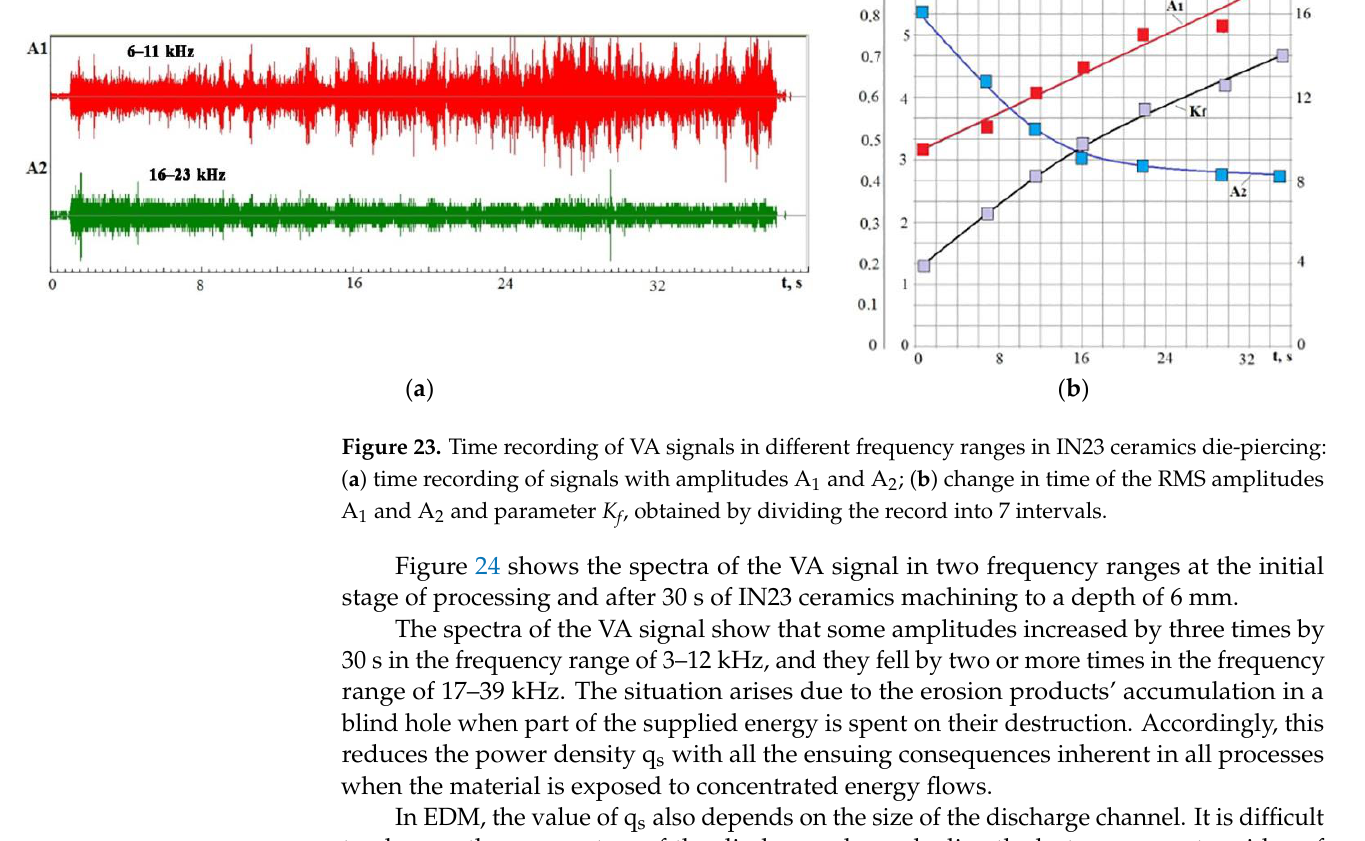
Figure 24. VA signal spectra for two frequency ranges for the initial and final stages of IN23 ce- ramics processing: ( a ) low frequency range; ( b ) high frequency range.